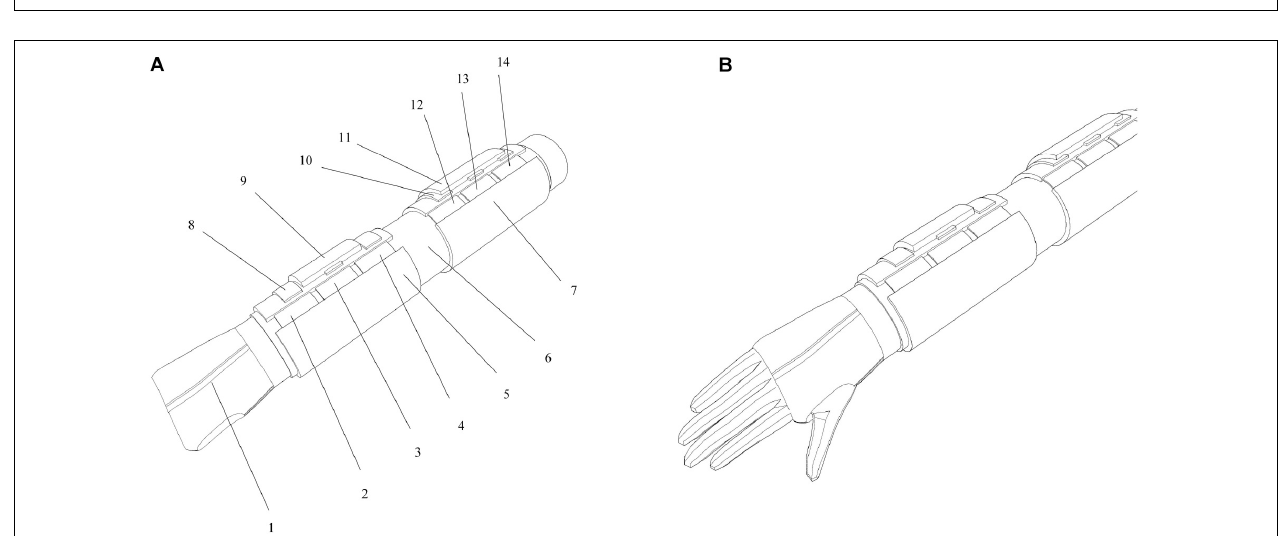
FIGURE 2 | Device diagram: (A) schematic diagram of the device structure and (B) device wearing diagram.